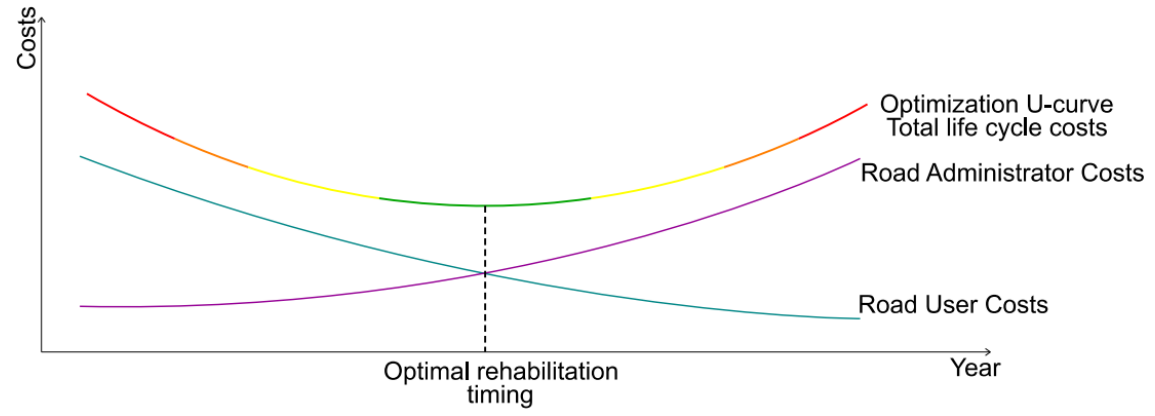
Figure 2. U-curve represent the optimal rehabilitation timing.